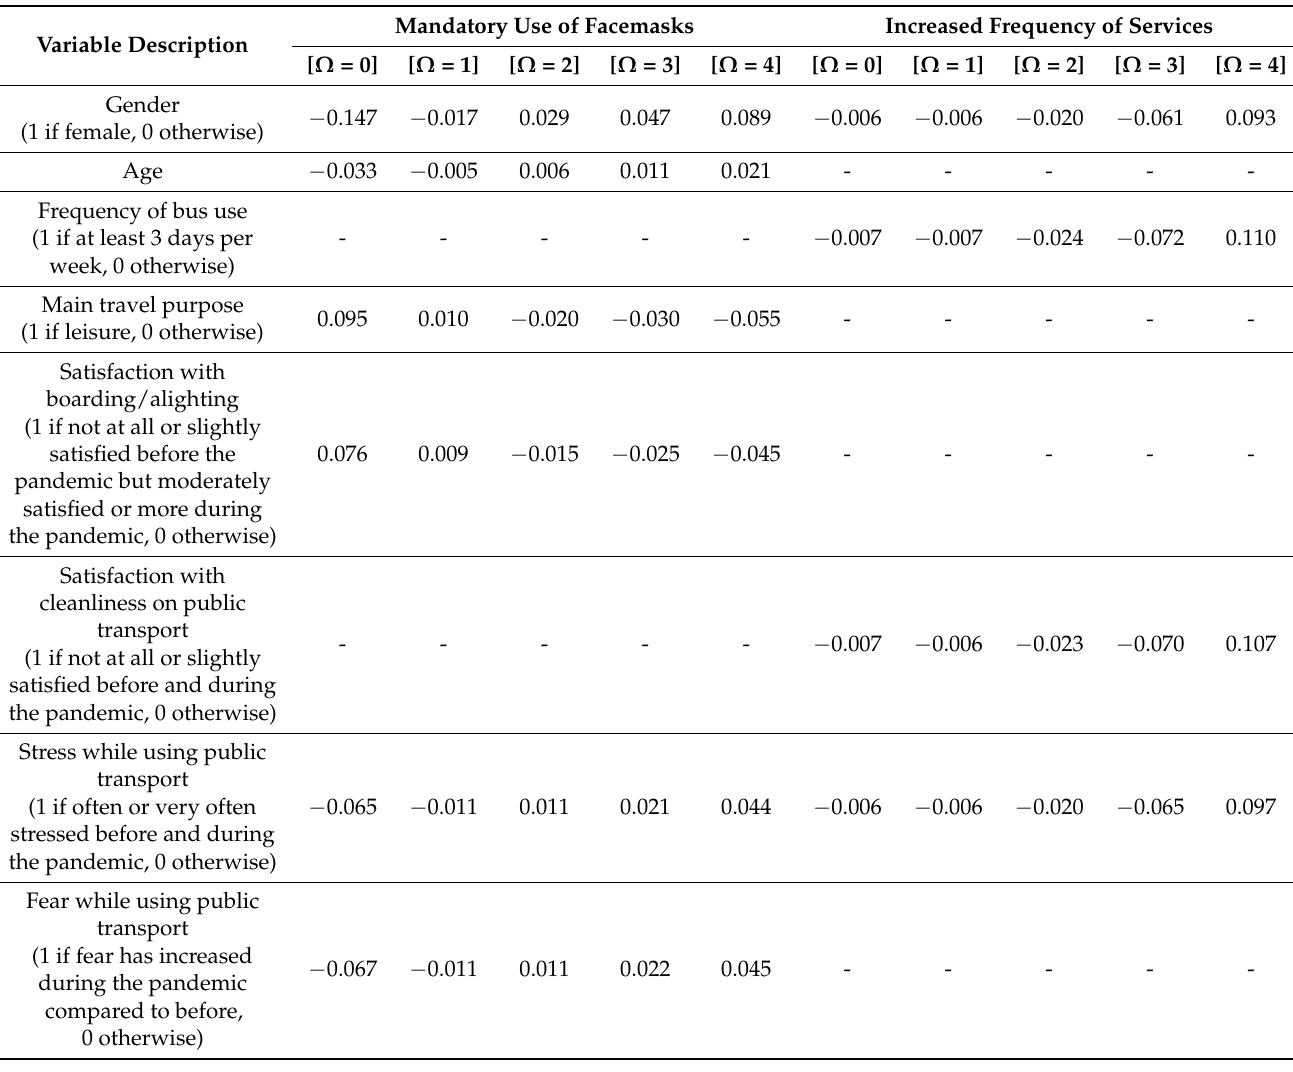
Table 5. Marginal effects of the variables included in the BOP model for attitudes towards policy measures on public transport